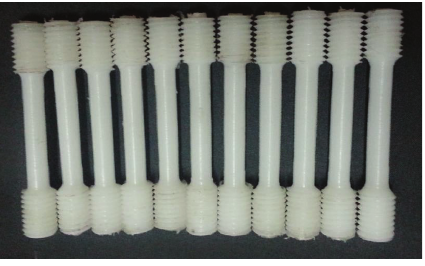
Figure 1: PVC samples.